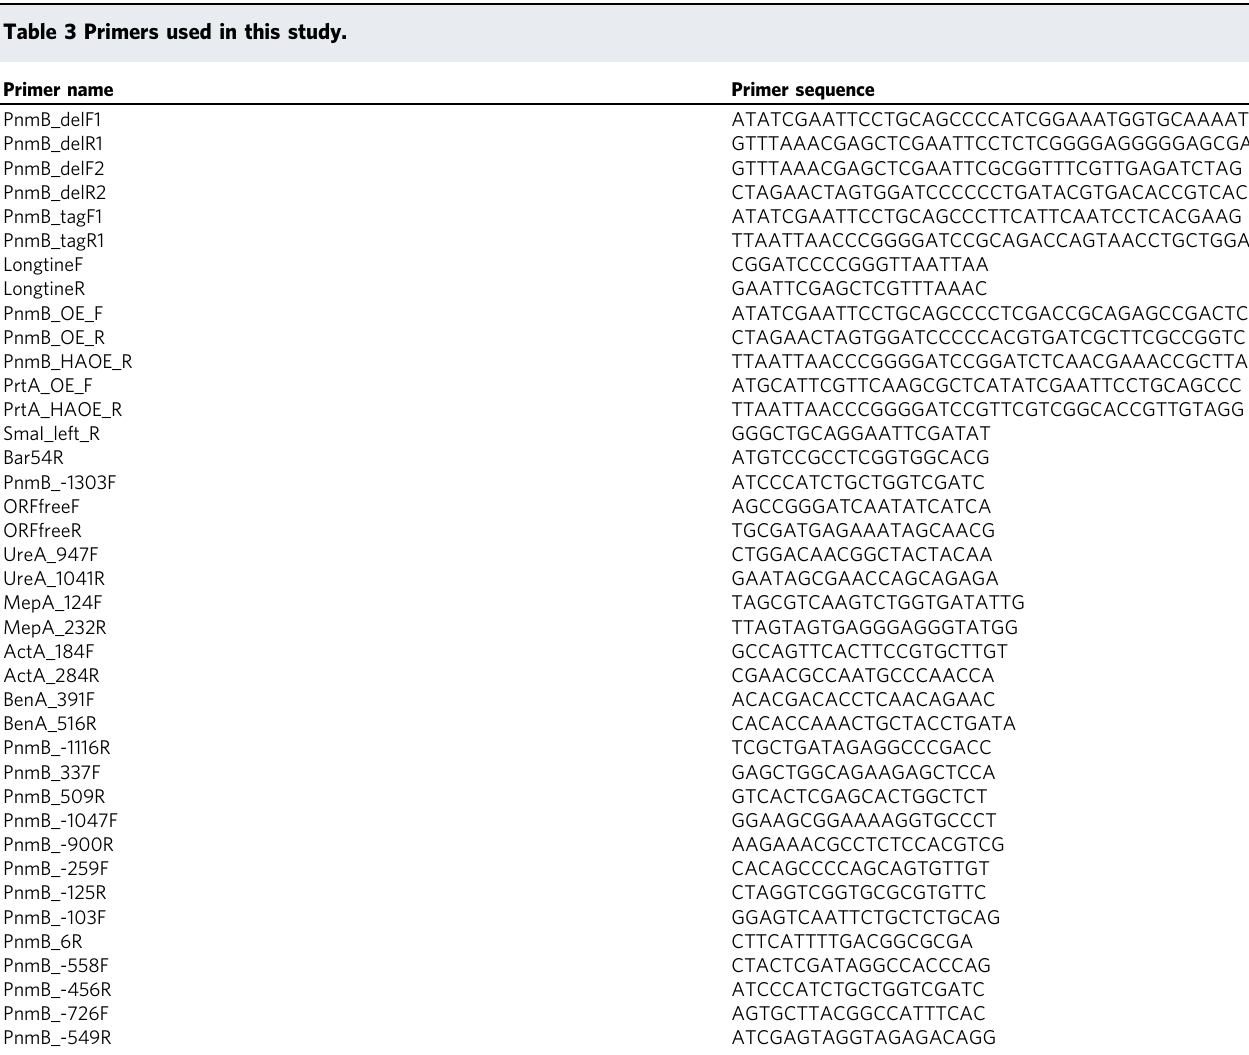
Table 3 Primers used in this